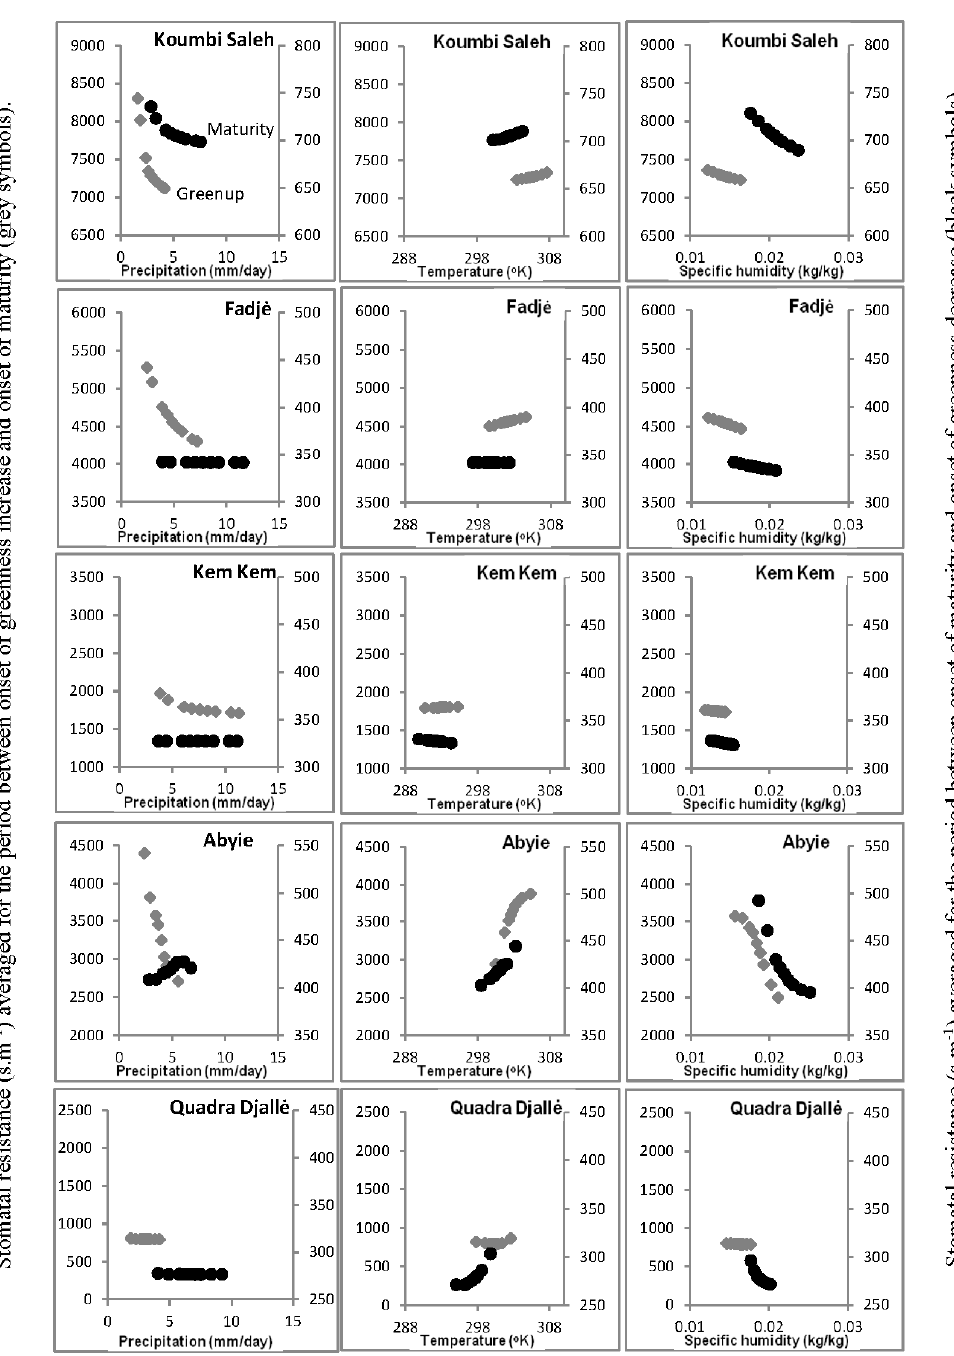
Figure 13. The response of stomatal resistance (s · m − 1 ) to changes in precipitation, temperature, and specific humidity averaged for the period from green-up to maturity (green-up period, grey diamonds; left hand axis) and from maturity to senescence (maturity period, black circles; right hand axis). Note the different ranges on the y axis between sites.